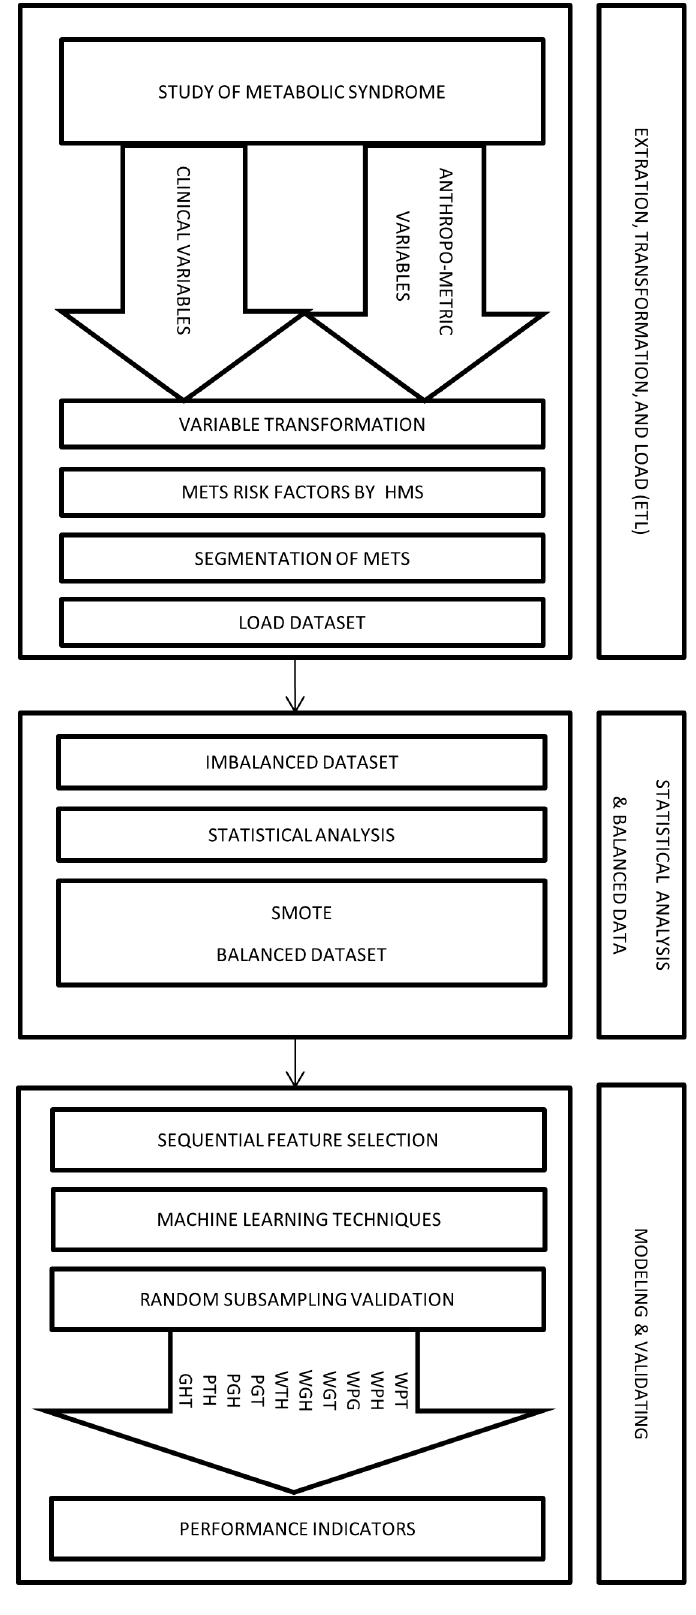
Figure 2. Framework to diagnose the types of MetS by HMS criterion using non-biochemical